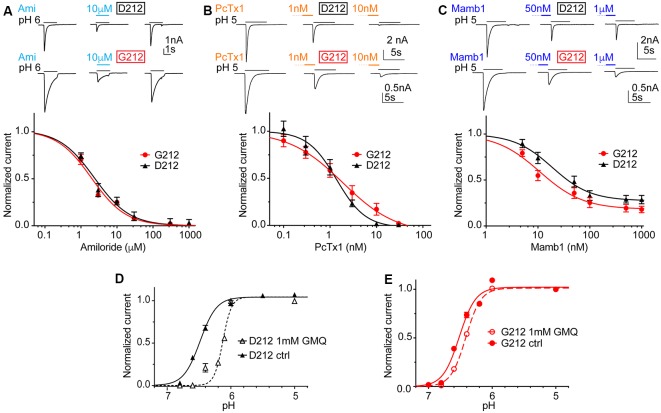
Unchanged pharmacology in hASIC1a-D212. All data in this figure are from hASIC1a expressed in CHO cells, measured with whole-cell patch-clamp; black symbols represent hASIC1a-D212, red symbols hASIC1a-G212. Conditioning pH was 7.4 in all experiments, and lines are fits to a Hill equation. (A) Top, representative current traces of ASIC1a activated by pH6.0 for 3 s without inhibitor, in the presence of 10 μM amiloride, and after washout of amiloride. Bottom, amiloride inhibition curve, plotting the current as a function of amiloride concentration, normalized to the response in the absence of amiloride, n = 4–5. (B) Top, representative current traces obtained under control conditions or after pre-administration of PcTx1 at the indicated concentrations. Bottom, PcTx1 inhibition curve, n = 6; PcTx1 was pre-applied in the conditioning pH solution during 60 s, before activating ASICs with pH5.0 during 5 s. (C) Top, representative current traces obtained under control conditions or after pre-administration of Mambalgin1 at the indicated concentrations. Bottom, Mambalgin1 inhibition curve, n = 7–8; Mambalgin1 was pre-applied in the conditioning pH solution during 60 s, before activating ASICs with pH5.0 during 5 s. (D,E) pH dependence of activation in the presence and absence of 1 mM 2-guanidine-4-methylquinazoline (GMQ) in the acidic solution; dotted lines and empty symbols represent the condition with GMQ. (D) D212, n = 10–11, p < 0.0001. (E) G212, n = 11–12, p < 0.01.